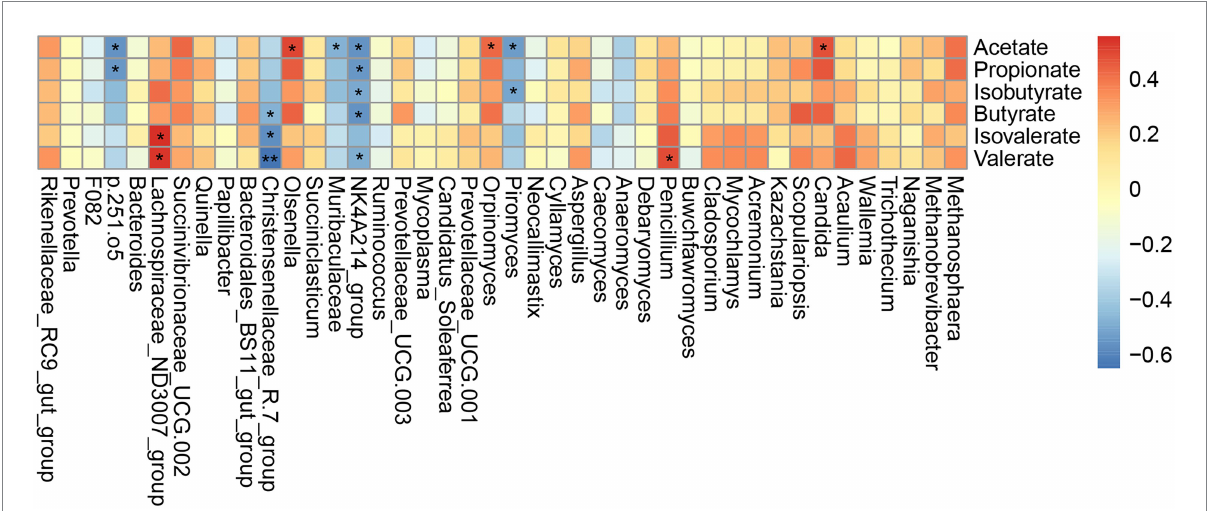
FIGURE 5 Correlations between the higher abundant genera of rumen microbial and VFAs. Each row in the graph represents a genus, each column represents a metabolite, and each lattice represents a Spearman’s correlation coefficient between a component and a metabolite. Red represents a positive correlation, while blue represents a negative correlation. * p < 0.05, ** p <